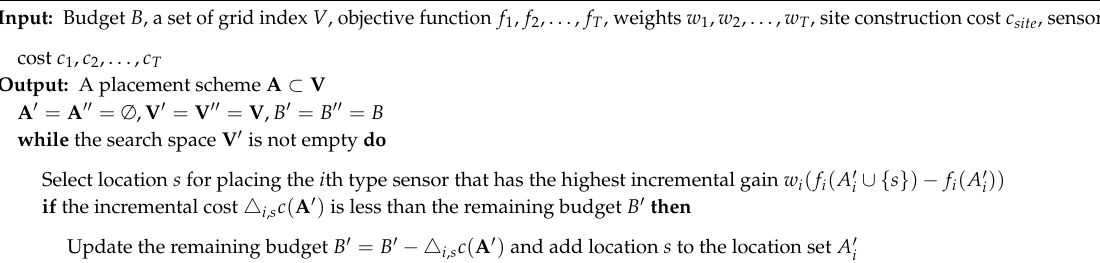
Algorithm 2 Multi-type sensor deployment algorithm for the general cost